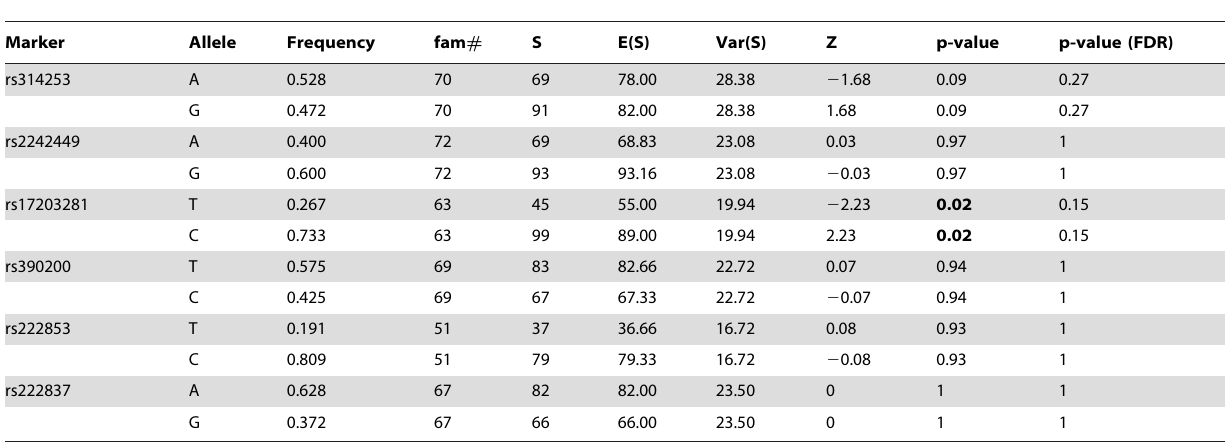
Table 1. FBAT analysis of the DLG4 in Japanese schizophrenia pedigree samples.